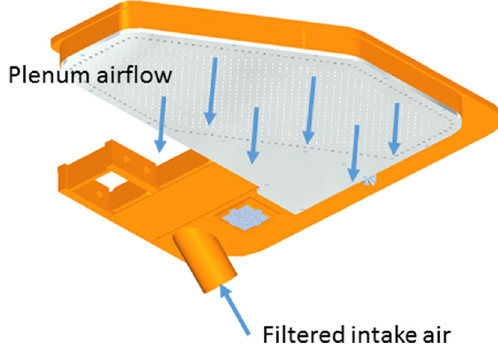
Fig. 2 3rd generation roof bolter canopy design with the new plenum design